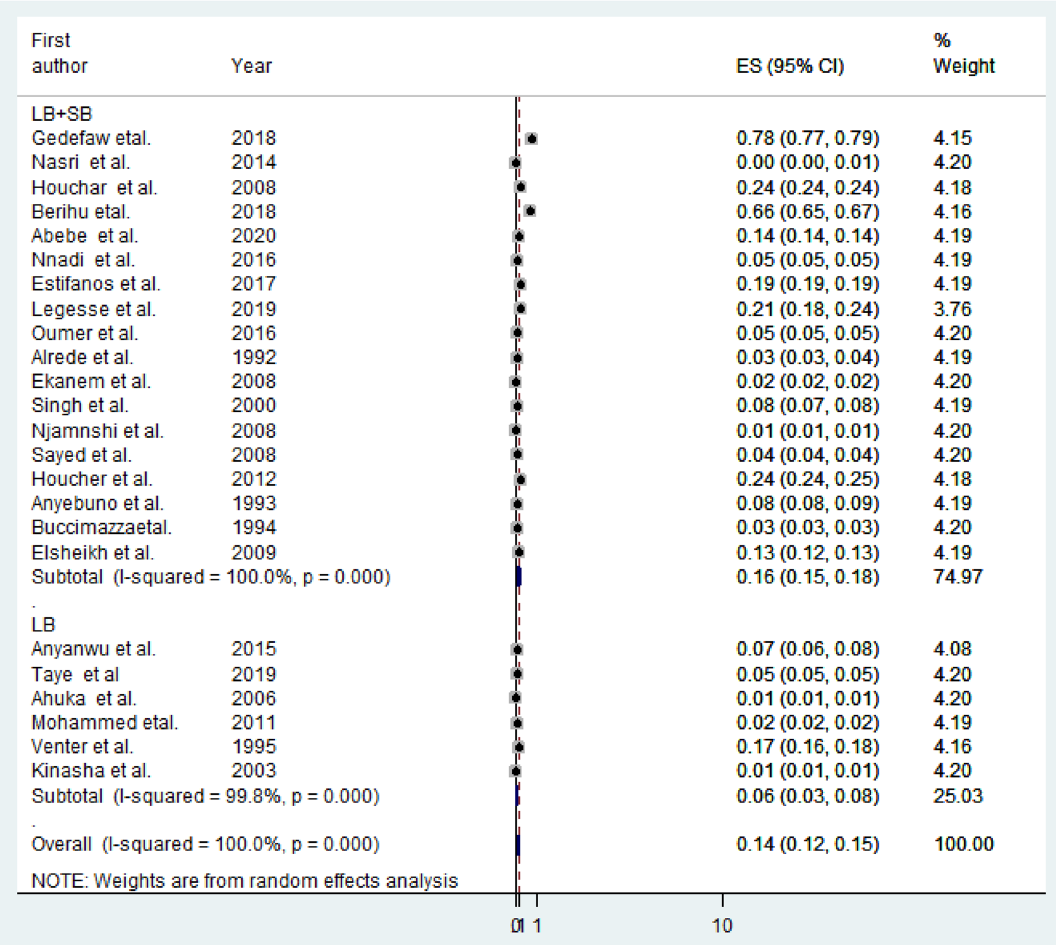
Figure 3. Sub-group analysis showing the pooled prevalence of anencephaly based on birth outcome (live births only (LB), live births and stillbirths (LB + SB)) in Africa,